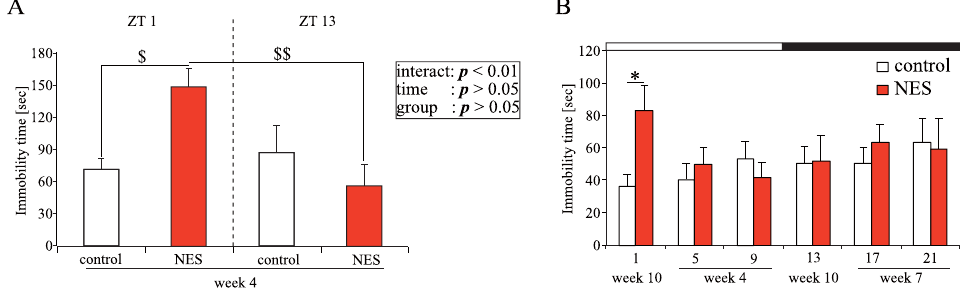
Figure 4. Effect of 5-min RF with HFD at ZT 5 on FST immobility time (Experiment 4). ( A ) The FST immobility time at ZT 1 and 13 in mice after 4 weeks of each feeding condition. The results of two-way ANOVA are presented on the right hand side of the graph. ( B ) The FST immobility time at ZT 1, 5, 9, 13, 17, and 21. The FST was conducted after 4 weeks of each feeding condition, with and interval between each FST of 2 weeks. The FST at ZT 5 and 9 were conducted in week 4, the FST at ZT 17 and 21 were conducted in week 7, and the FST at ZT 1 and 13 were conducted in week 10. Open and closed bars indicate light and dark periods, respectively. Data are presented as the mean ± SEM (the control group, n = 6; the NES model groups, n = 7). * p < 0.05 vs. the control group (Student’s t -test). $ p < 0.05, $$ p < 0.01 (two-way ANOVA with Tukey’s multiple comparison